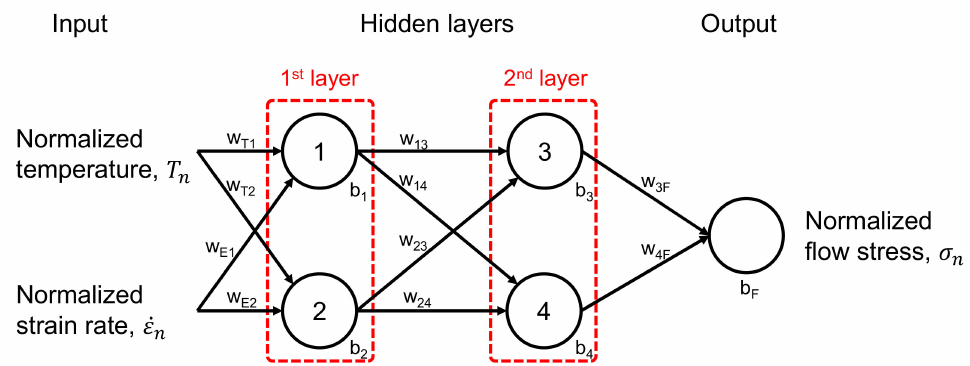
Figure 4. Structure of the artificial neural network for predicting the flow